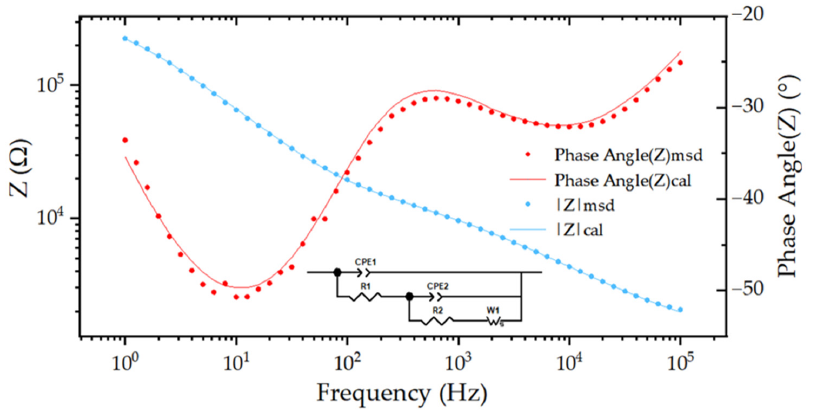
Figure 4. The equivalent circuit model and representative electrochemical impedance spectroscopy (EIS) of the soft neural electrode based on FPC technology and PDMS encapsulation layer. The symbols are measured EIS data, and the solid lines are fitted data by calculation. The inserted diagram is the corresponding equivalent circuit model.